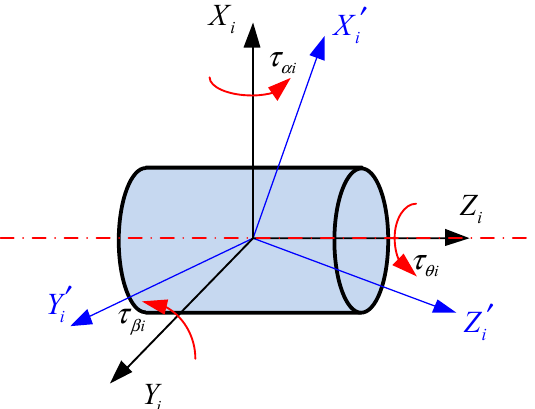
Figure 2. The differential motion of the joint coordinate system is caused by joint deformation. It can be seen from the differential motion that the end deformation D J θ caused by the torsion of the space manipulator joint and the end deformation D J α and D J β caused by the bending can be expressed as: